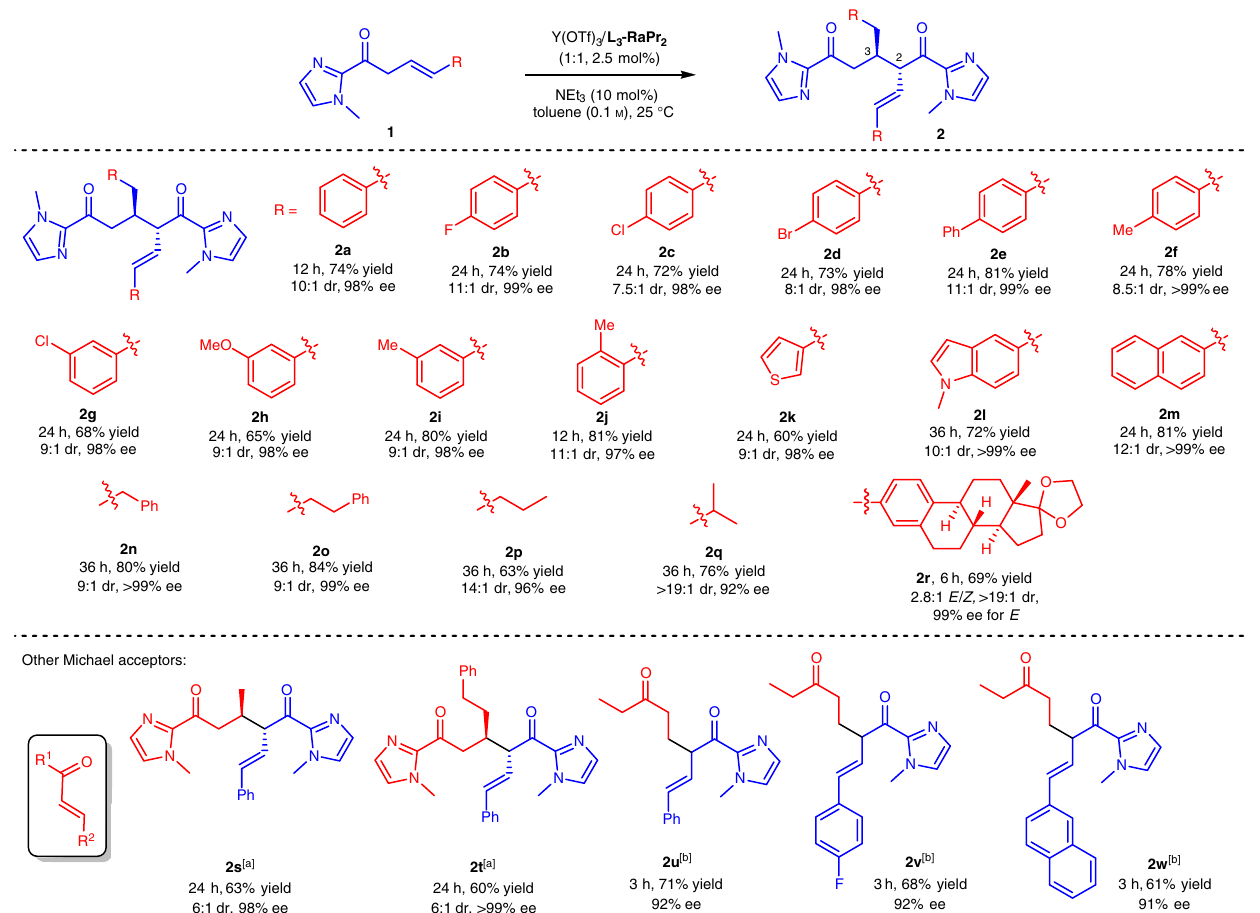
Fig. 3 Substrate scope in isomerization/ α -Michael addition reaction. Unless otherwise noted, all reactions were performed with Y(OTf) 3 / L 3 -RaPr 2 (1:1, 2.5 mol%), 1 (0.20 mmol), NEt 3 (10 mol%) in toluene (1.0 mL) at 25 °C under N 2 atmosphere. The yield was based on isolated anti -isomer. The dr value was determined by 1 H NMR of crude products. The ee value was determined by HPLC analysis on chiral stationary phases. The substrates 1l and 1n – 1r were used as Z / E mixutres. [a] 5 mol% catalyst was used for 2s and 2t . [b] With 5 mol% Y(OTf) 3 / L 3 -RaPr 2 - 1-Ad as a catalyst and CH 2 Cl 2 as a solvent in the absence of NEt 3 for 2u – 2w